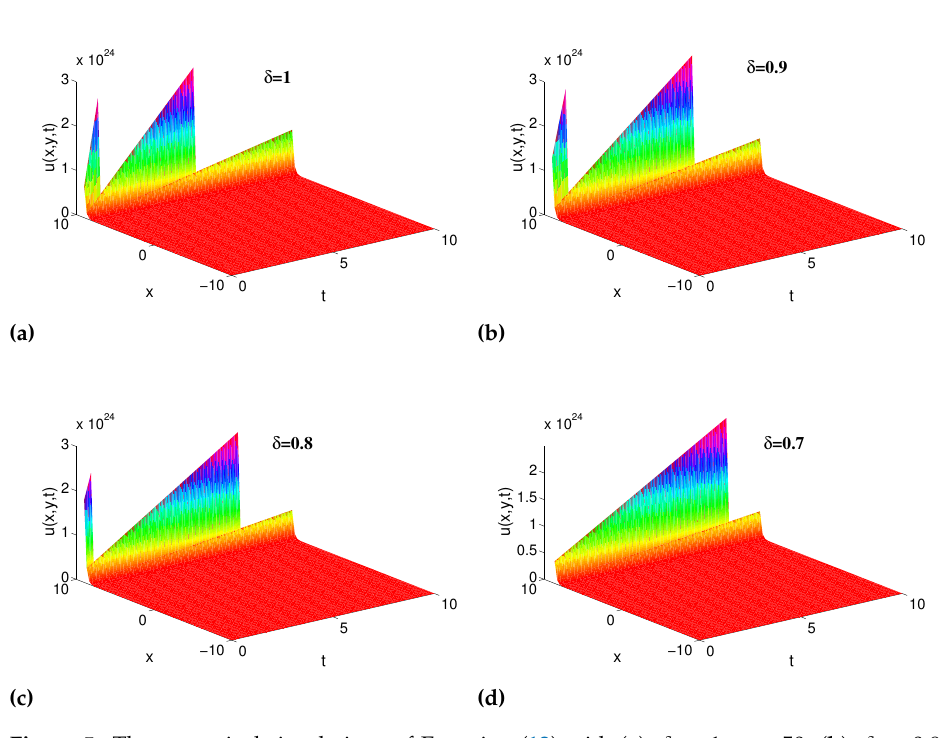
Figure 5. The numerical simulations of Equation (12) with ( a ) δ = 1, r = 50 ( b ) δ = 0.9, r = 50 ( c ) δ = 0.8, r = 50 ( d ) δ = 0.7, r = 50 and y = 2.